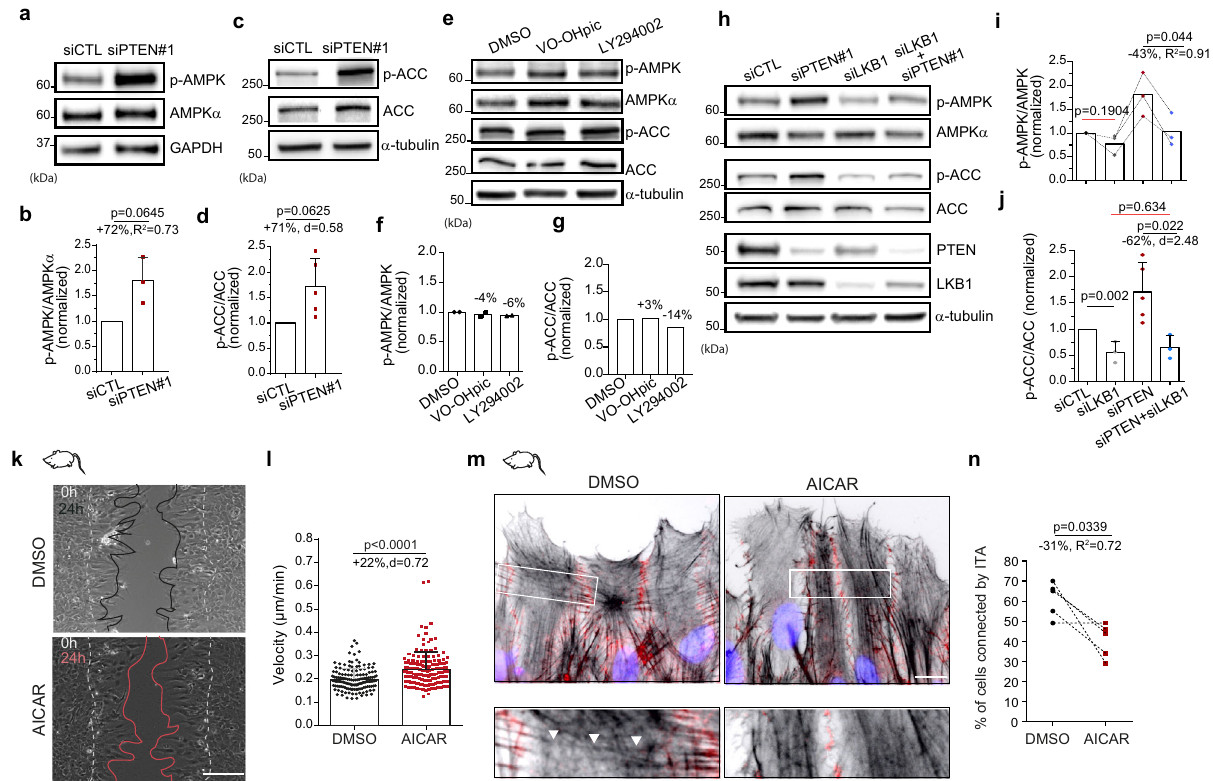
Fig. 3 PTEN inhibits AMPK activity to control collective cell migration. a , c , e Western blot analysis of phosphorylated AMPK (T172), total AMPK, phosphorylated ACC (S79), ACC and GAPDH in siCTL and siPTEN#1 ( a , c ) and DMSO, VO-OHpic, LY294002-treated ( e ) astrocytes lysates. b , f Normalised ratio (over siCTL or DMSO) of T172 phosphorylation/total AMPK in siPTEN#1 ( b , N = 3) and VO-OHpic- or LY294002-treated cells ( f , N = 2). Two-sided paired t -test were realised on raw data to generate p values. d , g Normalised ratio (over siCTL or DMSO) of S79 phosphorylation/ total ACC in siPTEN#1 ( d , N = 5, Wilcoxon test) and VO-OHpic- or LY294002-treated cells ( g , N = 1). h Representative western blot analysis of pAMPK (T172), total AMPK, ACC, pACC (S79), PTEN, LKB1 and α -tubulin in siCTL, siPTEN#1, si LKB1 and siPTEN#1 + siLKB1 astrocytes lysates. The analysis was repeated three times and analysed in ( i , j ). i Normalised ratio (over siCTL) of p-AMPK/AMPK ( N = 3, two-tailed paired t -test on raw data). j Normalised ratio (over siCTL) of p-ACC/ACC ( N = 3 for siLKB1 and siPTEN + siLKB1, N = 5 for siCTL and siPTEN, two-tailed unpaired t -test on raw data). Note that LKB1 depletion rescues basal AMPK activity in siPTEN#1 cells. k Representative phase-contrast images of DMSO and AICAR-treated astrocytes migrating in a wound-healing assay. White dashed lines delineate the border of the wound at t = 0. Black/Red lines delineate the border of the monolayer 24 h later. Scale bar: 100 µ m. l Mean velocity of DMSO ( n = 149) and AICAR-treated cells ( n = 157). Data were acquired from three biologically independent experiments and analysed statistically using two-tailed Mann – Whitney test. m Immuno fl uorescence images of actin fi laments (Phalloidin, black), cell-cell junctions (N-cadherin, red) and nucleus (DAPI, blue) in DMSO and AICAR-treated migrating astrocytes. Boxed regions are zoomed in the panels below to highlight the presence of ITA (white arrowheads) mostly in DMSO cells. Scale bar: 10 µ m. n Proportion of front row DMSO and AICAR-treated cells connected by ITA. 300 cells over fi ve biologically independent experiments were examined. Stasticial test: two-tailed paired t -test. Error bars represent SD. Full scan images of the blots and source data are provided as a Source Data fi